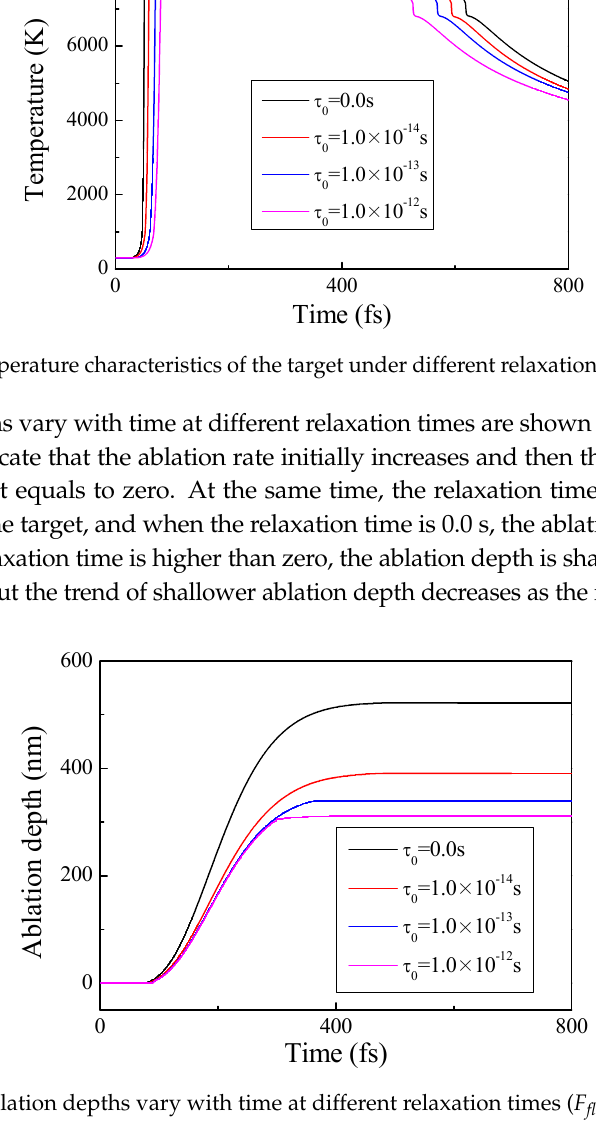
Figure 4. The temperature variation in the surface layer of target at different relaxation time ( F fluence = 10 J/cm 2 ).